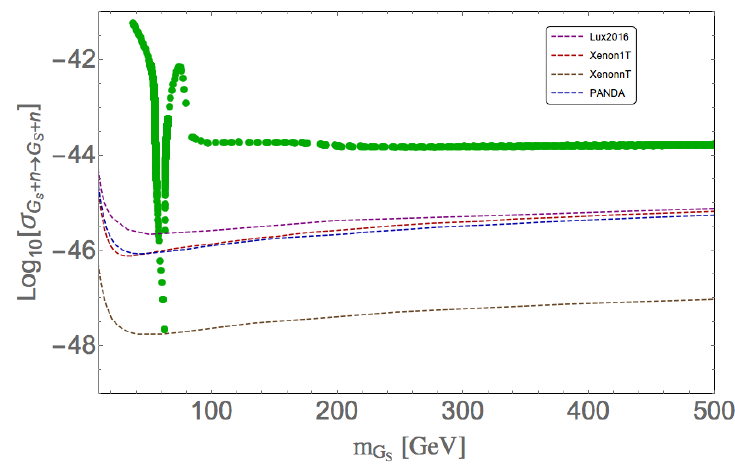
Figure 5 . Spin-independent DM-nucleon cross section as a function of the DM mass, for tan (cid:12) = 10 for the case of 15 degenerate pNBG DM. Bounds from LUX 2016 [54], Xenon1T [55] and PANDA X [56] are shown with the expected sensitivity from XENONnT